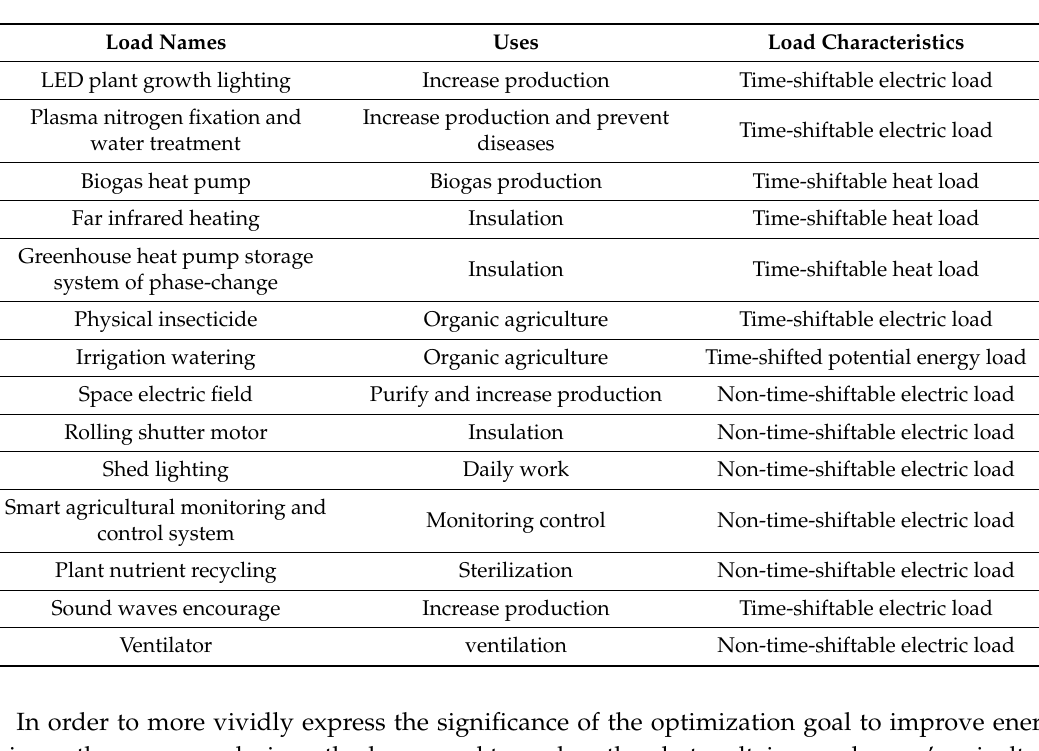
Table 1. Load characteristics classification in photovoltaic greenhouse facilities agricultural micro energy networks.